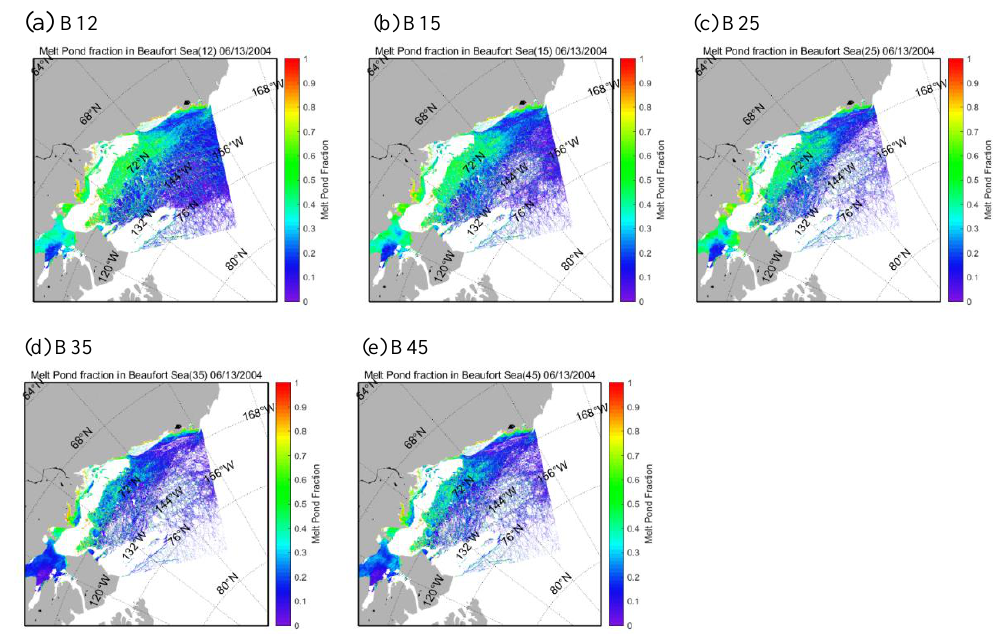
Figure 3 MPF retrieval result using two-band algorithm in different